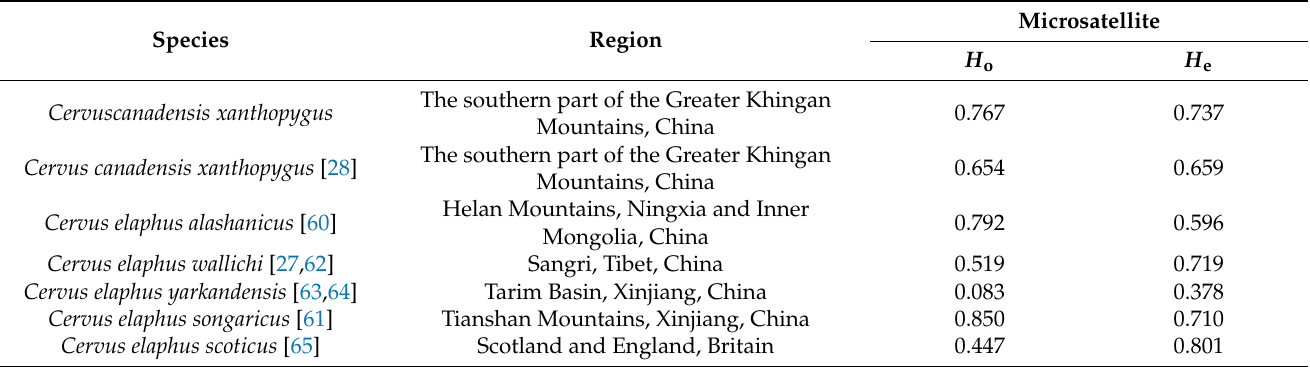
Table 5. Comparison of genetic diversity in the Cervus populations among different